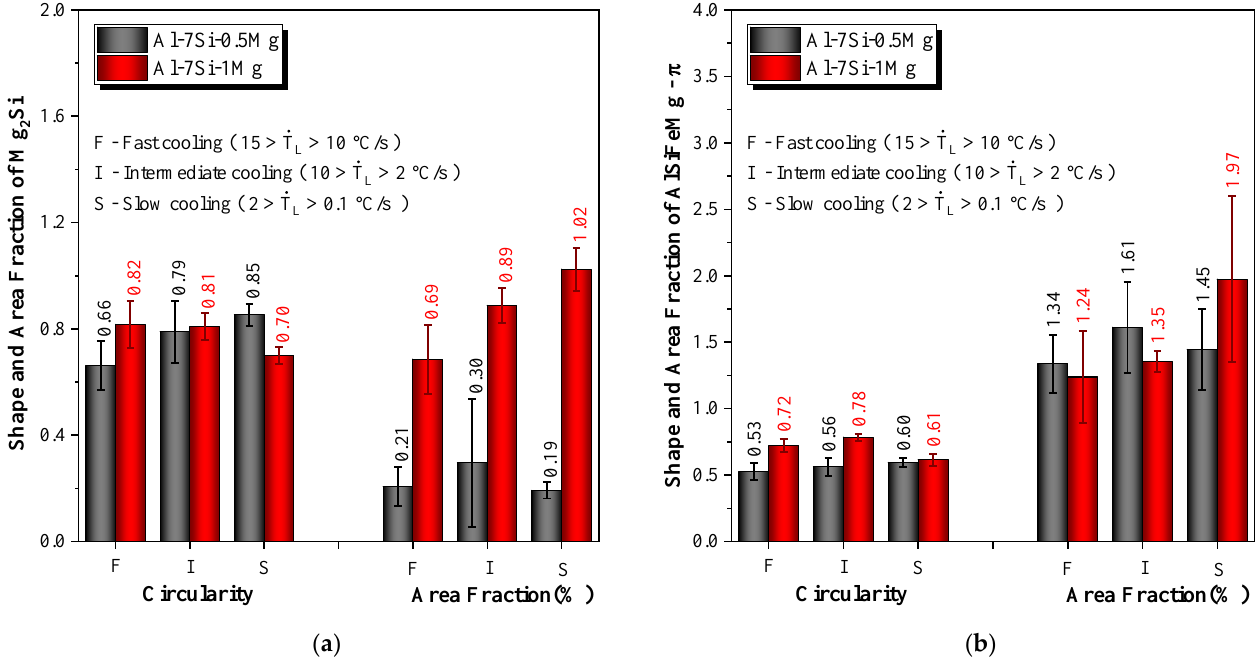
Figure 8. Column graphs of the circularity and area fraction of the ( a ) Mg 2 Si and ( b ) Al-Si-Fe-Mg IMCs in the Al-7Si-(0.5 and 1) alloys for three different ranges of cooling rates.